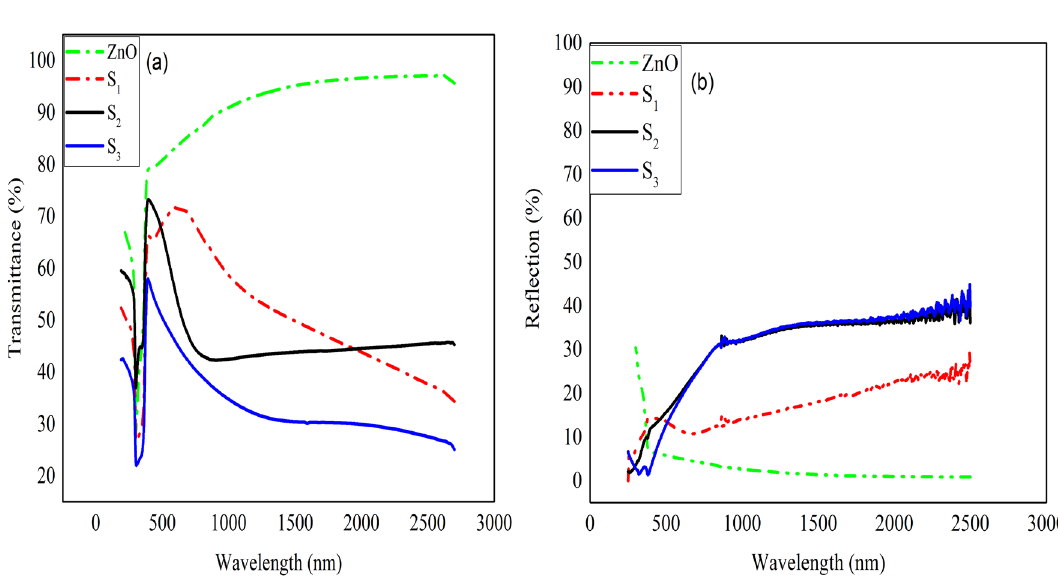
Figure 3. The transmittance and reflection spectra.